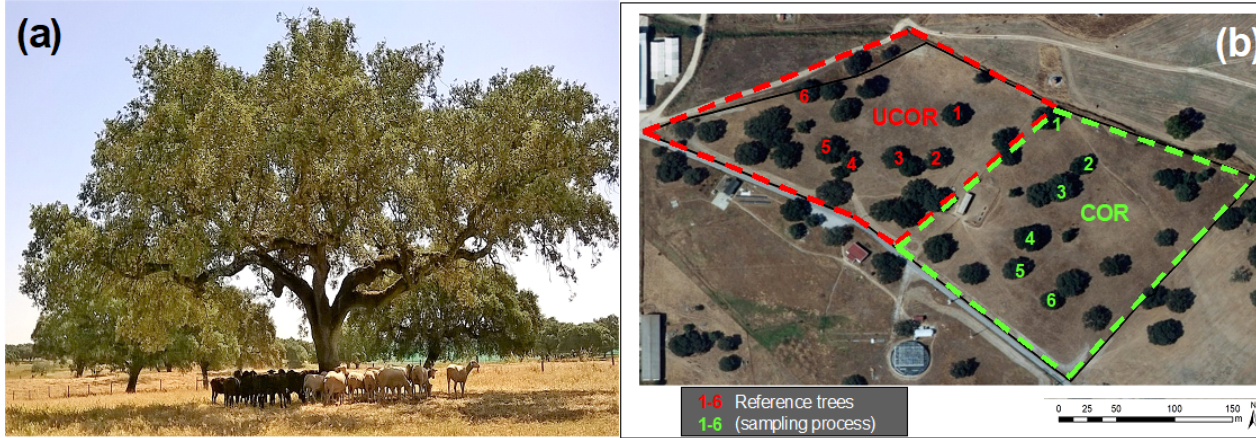
Figure 1. Experimental field: ( a ) picture of montado ecosystem; ( b ) sampling areas, amended and unamended (COR and UCOR, respectively) and the six trees used in each area as reference in sampling process.